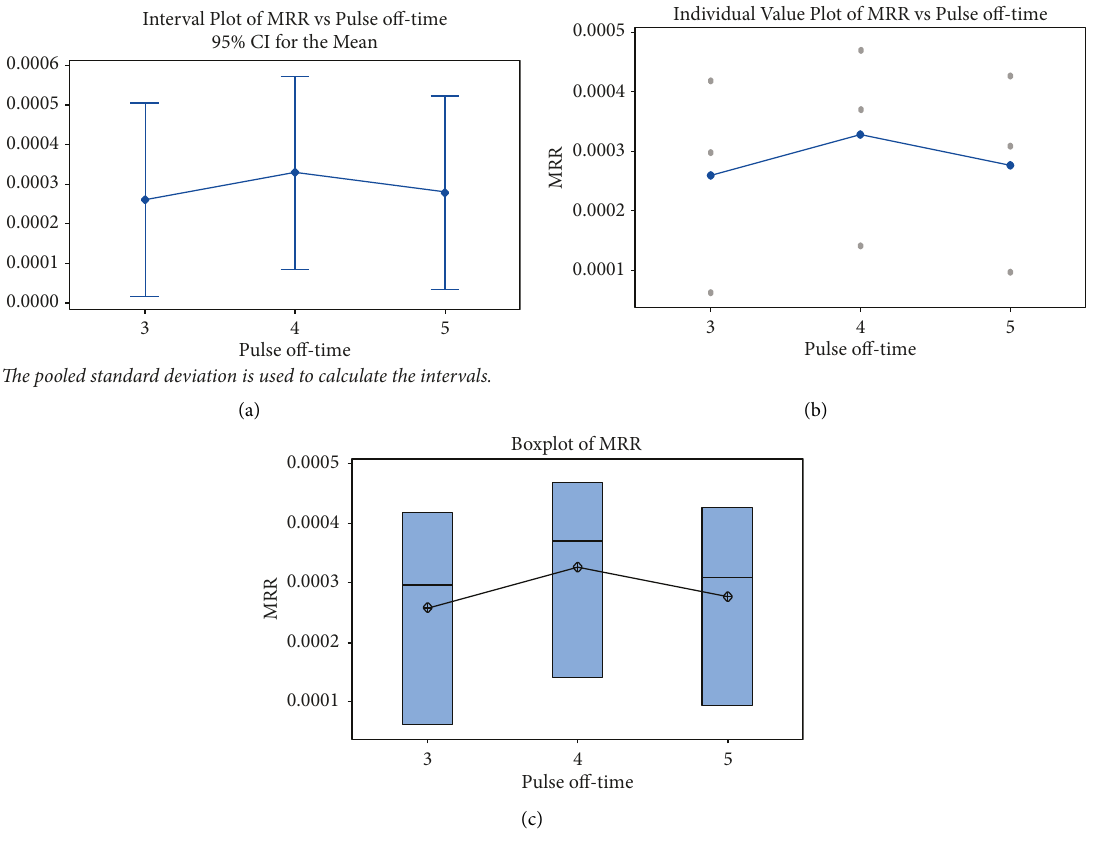
Figure 10: (a) Interval plot of MRR vs pulse-off time for mild steel. (b) Individual value plot of MRR vs pulse-off time for mild steel. (c) Boxplot of MRR vs pulse-off time for mild